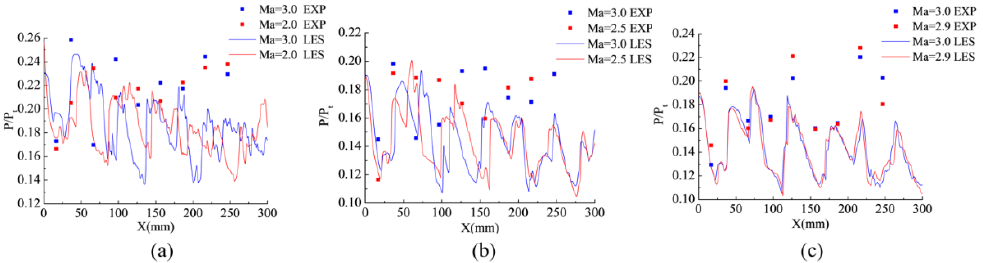
Figure 10. Comparisons of experiments and LES simulation on the streamwise pressure distribution ( a ) case 1, ( b ) case 2, ( c ) case 3.